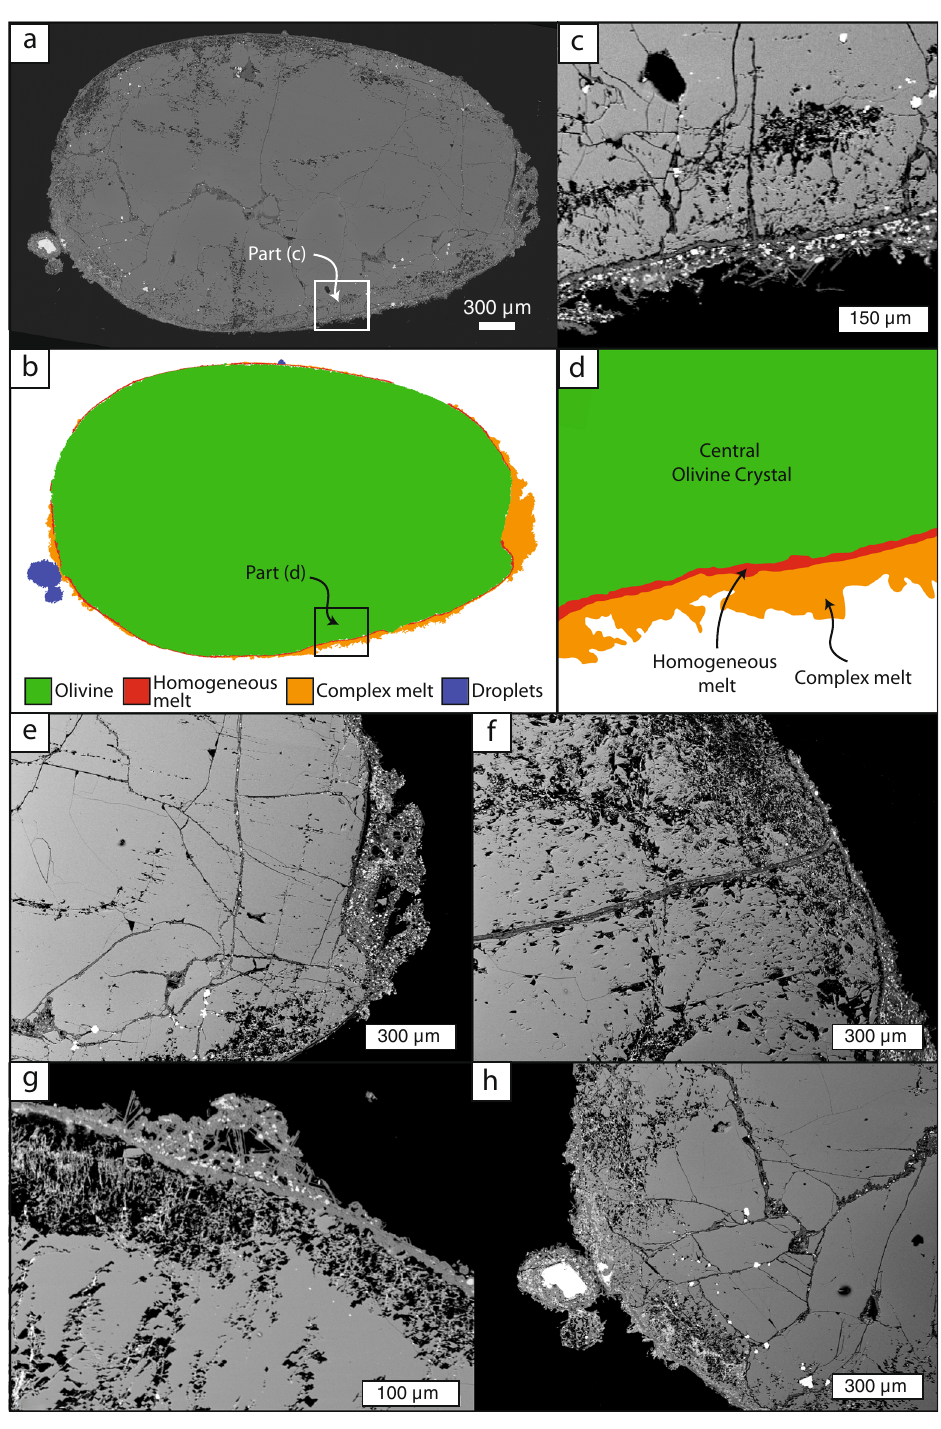
Fig. 2 SEM images showcasing the textural features preserved in olivine-cored pelletal pyroclasts. a A large image mosaic of an IHV complex pelletal pyroclast with b the accompanying trace and labelled features. Green represents the olivine crystal, red the homogenous melt, orange the complex melt and dark blue represents adhering droplets. c A close-up view of the olivine crystal — melt interface, where a homogeneous quenched melt layer (now glass) can be seen at the interface overlain in places by more crystal-rich material. The accompanying trace with feature identi fi cations are shown in d at the same scale. e Preferential thickening of the coating within a depression on the olivine crystal surface. f Internal melt- fi lled cracks that connect to the surface and the melt coating. g A spreading droplet on top of the quenched, homogeneous layer. h Sticking, circular, undeformed droplets tacked on to the main